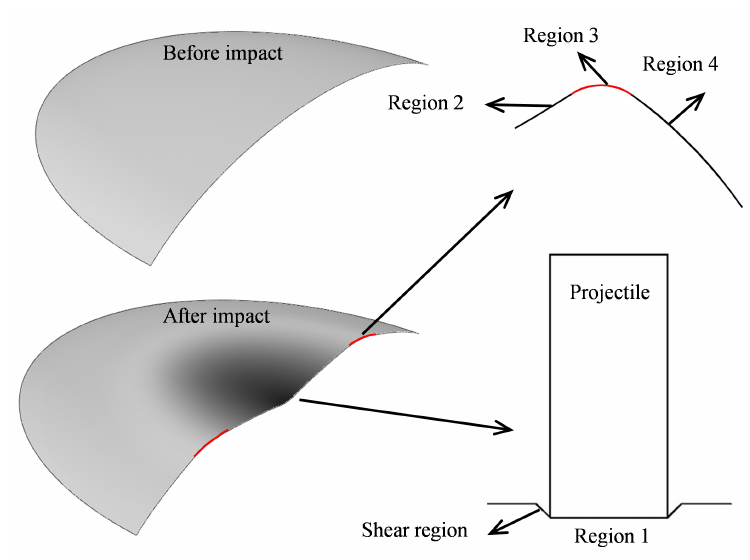
Figure 9. Deformation features of an impacted ellipsoidal shell. The displacement of Region 1 is represented by w 1 = γ . According to isometric transformation, the shape of Region 2 was symmetrical to the original shell on the plane z = z f . Considering a rigid displacement z h led by the inner boundary between Region 2 and Region 3, the displacement distribution of Region 2 of an impacted ellipsoidal shell was shown as w 2 = z h + 2 ( z − z f ) . The displacement w 3 in Region 3 was assumed to be a second-order polynomial distribution in the impact direction. This distribution was solved by zero- and first-order continuous conditions that needed to be satisfied in both of the two boundaries of Region 3, that is the inner boundary between Regions 2 and 3 and the outer boundary between Regions 3 and 4. The solved displacement distribution of Region 3 is shown in Equation (1), combined with the displacement of Regions 1 and